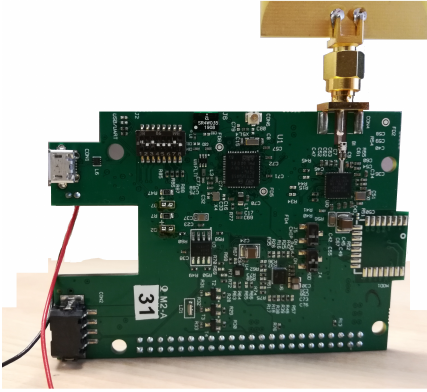
Figure 7. UWB Anchor